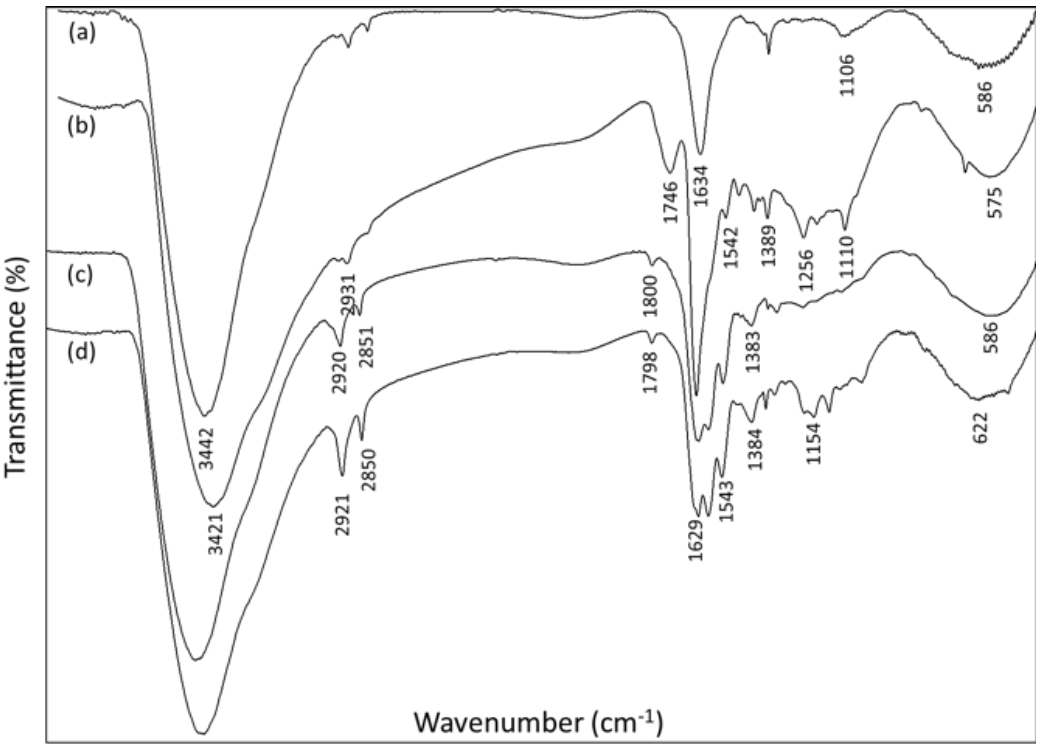
Figure 3. Zeta potential distribution for ( A ) ND-SQ1, ( B ) ND-SQ2, and ( C ) ND-SQ3.